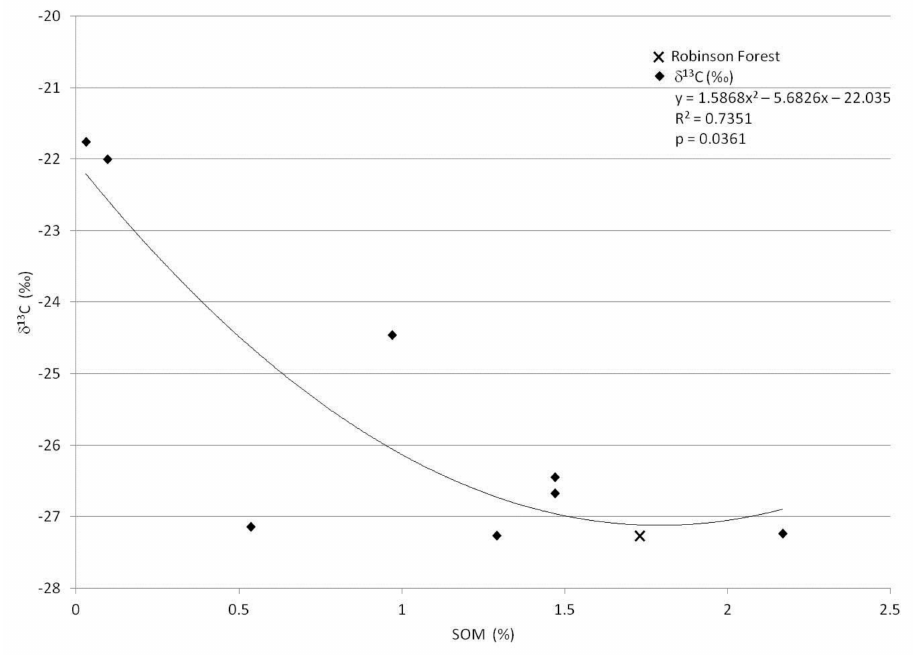
Figure 7. Correlation between % SOM (thermogravimetric analysis) and δ 13 C ( ‰ ) in mine soils representing a range of time since reclamation, with Robinson Forest plotted for